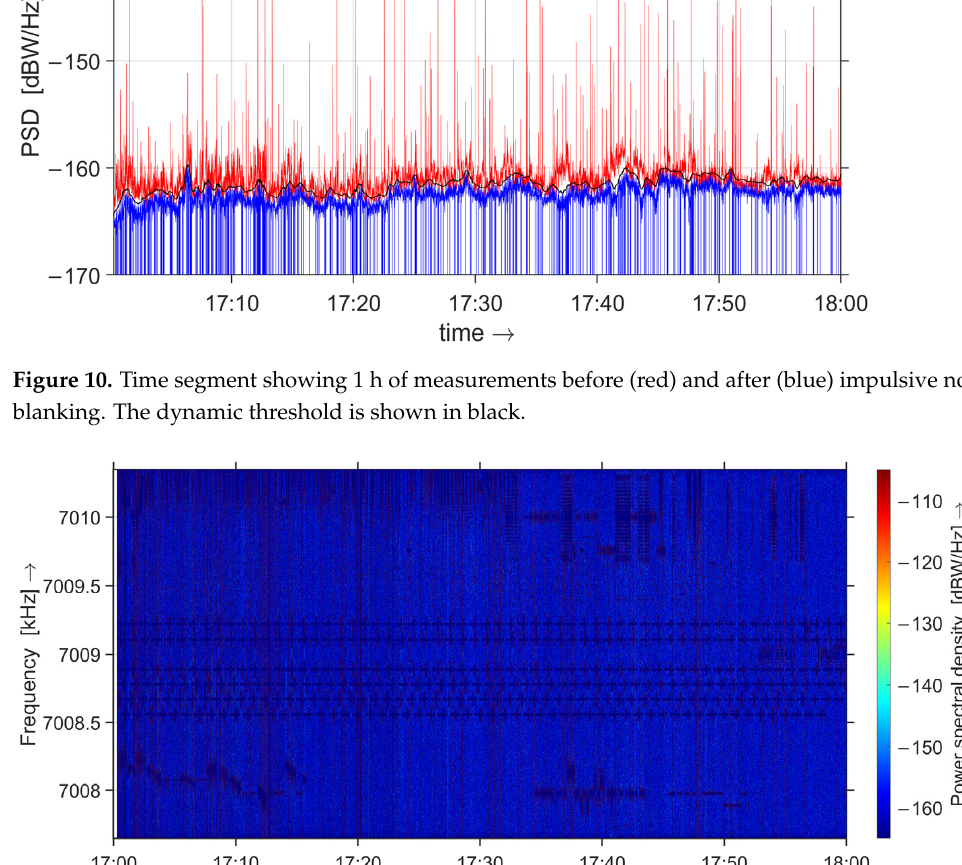
Figure 11. Spectrogram of the same 1-h time fragment of measurements as in Figure 9, but after removal of wideband impulsive noise. Only the background ambient noise remains.